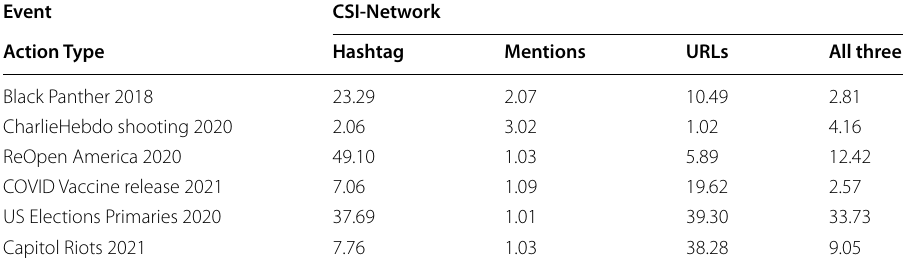
Table 8 Comparison of CSI-Network scores for one action type versus multiple action types